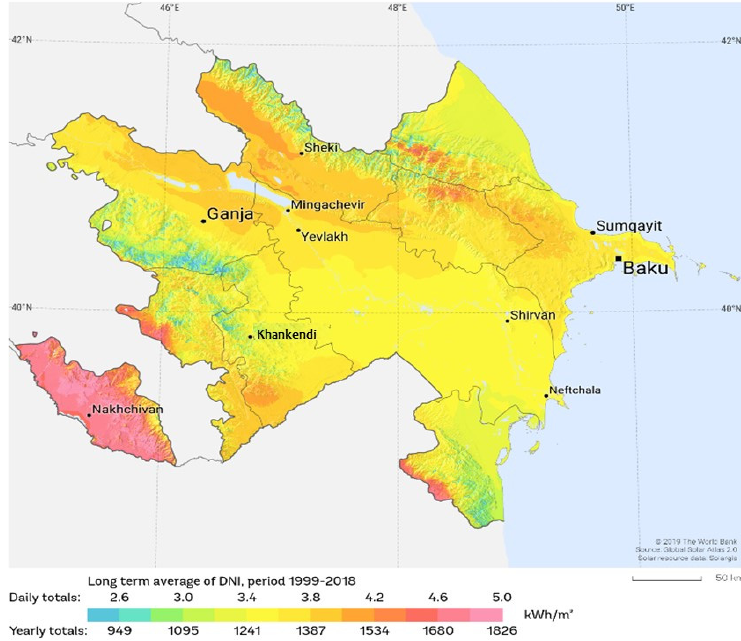
Figure 6. Global Horizontal Irradiation map of Azerbaijan [26].